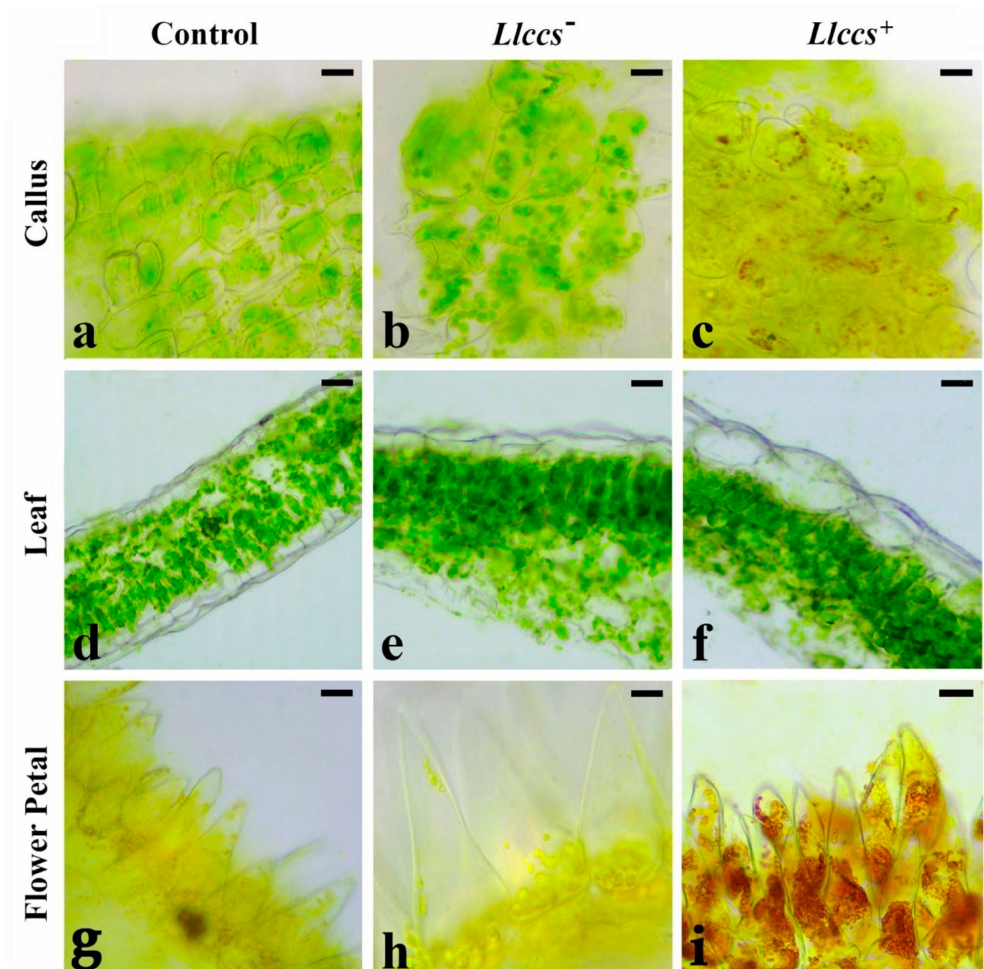
Figure 9. Histological analysis ofcalli, leaves and flower petals of control and transgenic Llccs − and Llccs + V. cornuta plants. ( a – c ) Cells of control ( a ), Llccs − ( b ) and Llccs + ( c ) Callus tissue; ( d – f ) Cross sections of control ( d ), Llccs − ( e ) and Llccs + ( f ) leaves; ( g – i ) Epidermal cells on the adaxial side of control ( d ), Llccs − ( e ) and Llccs + ( f ) flower petals. Note the accumulation of newly synthesized pigment in the chromoplasts of Llccs + callus cells ( c ) and in the epidermal cells in adaxial side of fully opened flowers ( i ). Bars: 200 µ